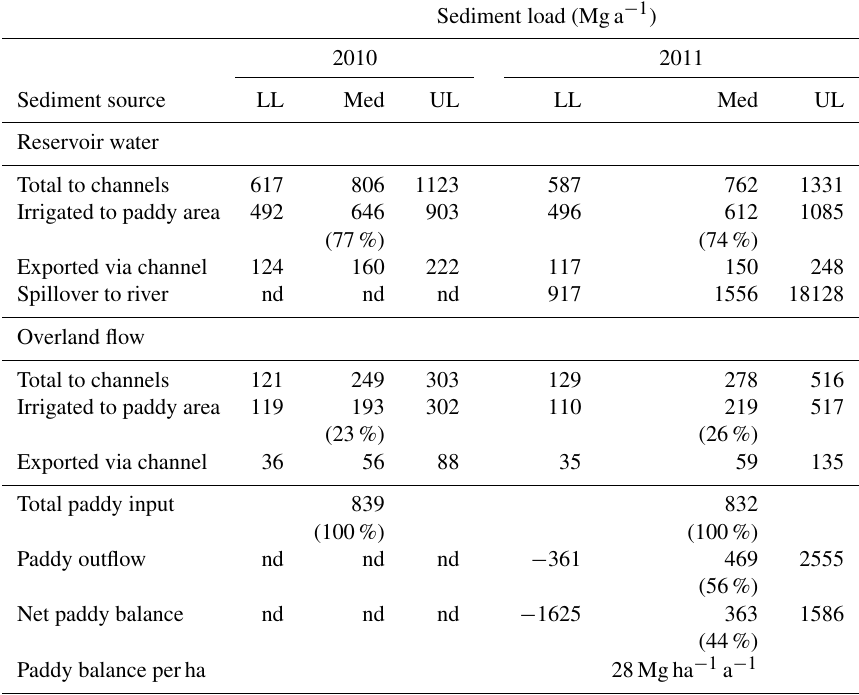
Table 3. Sediment inputs from irrigation water and overland flow from the 37ha upland area in the subwatershed, and sediment export and trapping by the 13ha paddy area (Figs. 1 and S1). Loads are estimated as the median of the bootstrap estimates (Med) and therefore do not always sum up exactly within columns, and 95% confidence intervals are shown (LL is the lower limit, UL is the upper limit) inMg per year (Mga − 1 )